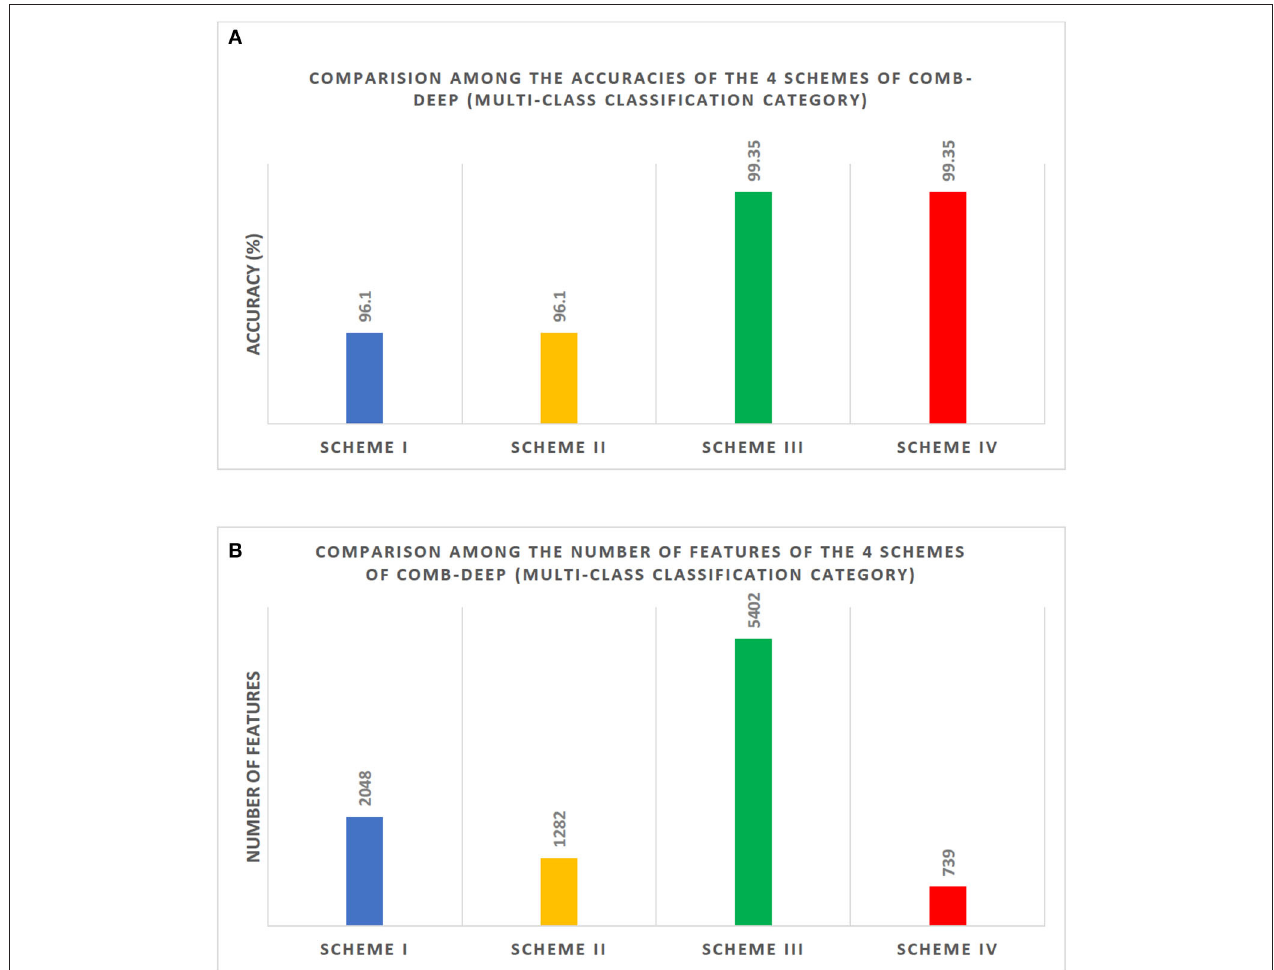
FIGURE 7 | Comparison between the four schemes of the multi-class classification category of CoMB-Deep. (A) The highest classification accuracy (%) attained using the four schemes. (B) The number of features utilized in the four schemes. Scheme I: ResNet-50 or DenseNet-201; Scheme II: DenseNet-201 Scheme III: DenseNet-201 Inception V3 Shuffle Squeeze ResNet-50 MobileNet DarkNet-53 NasNetMobile; Scheme IV: DenseNet-201 + + + + + + + V3 Shuffle Squeeze ResNet-50 MobileNet DarkNet-53 + + + + + +